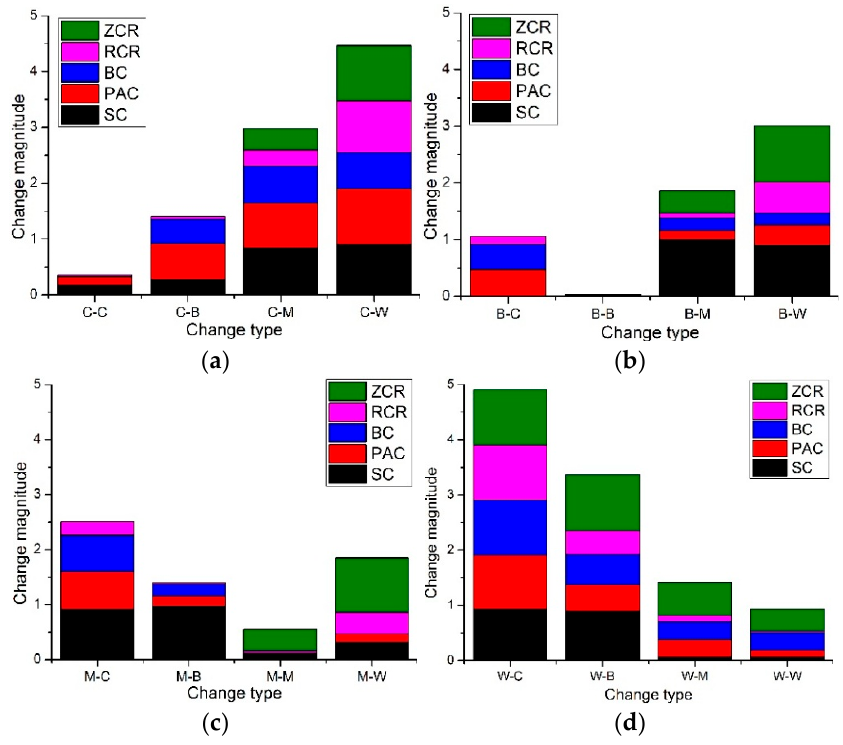
Figure 11. The components of the integrated change magnitude of land cover types, where ZCR, BC, RCR, PA, and SC label the contributions from the change magnitudes of the zero-crossing rate, baseline cumulation, relative cumulation rate, phase angle, and spectral correlation. The conversions from 2010 to 2015 are expressed as “type-type” in the x -axis, the subfigures ( a ), ( b ), ( c ) and ( d ) mainly show the conversions from crop, built-up, muddy water and water of 2010 to according land cover types of 2015, respectively, where B = built-up, C = crop, M = muddy water, and W = water.